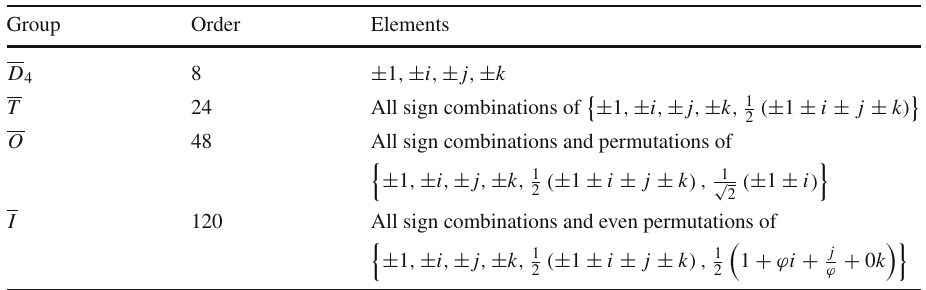
(cid:4) (cid:3) ± 1 , ± i , ± j , ± k , 1 ( ± 1 ± i ± j ± k ) 2